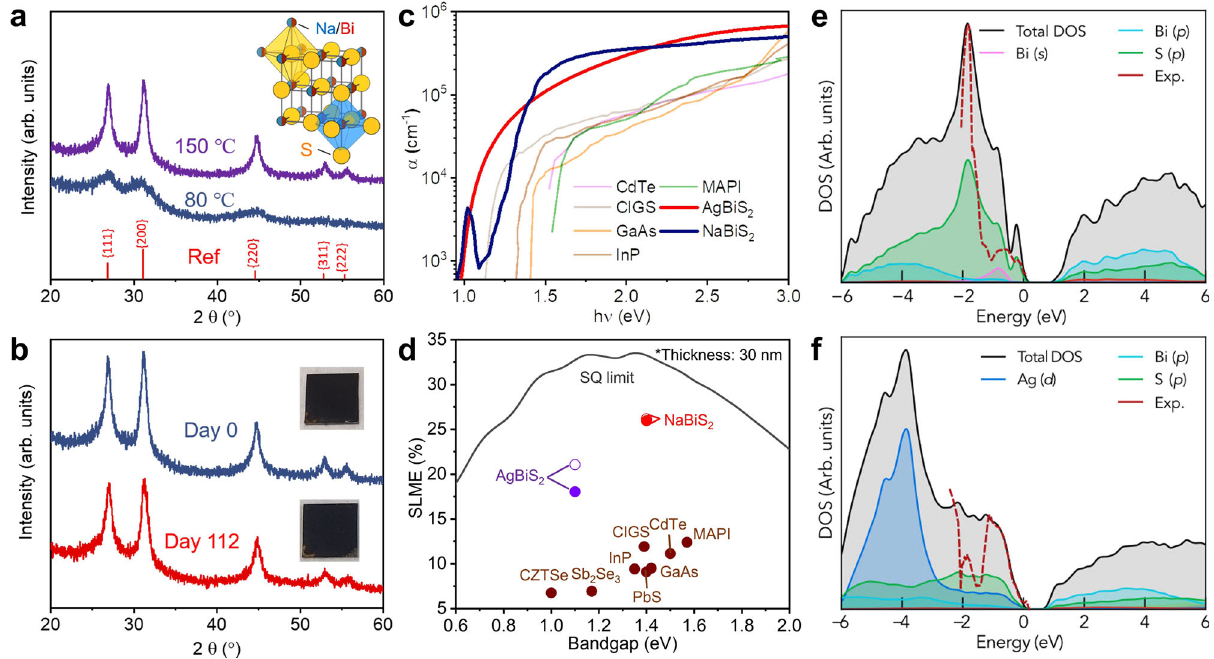
Fig. 1 | Structural and optical properties of NaBiS 2 NC fi lms. a X-ray diffraction (XRD) patterns of NaBiS 2 nanocrystals (NCs) synthesized at 80°C and 150°C compared with the referencepatternfor the disordered rocksalt ( Fm (cid:1) 3 m ) phase of NaBiS 2 28 . b XRDpatternsandphotographsofNaBiS 2 NC fi lmssynthesizedat150°C on the same day of preparation (Day 0) and after 112 days (Day 112) of storage in ambient air (60 – 70% relative humidity). c Absorption coef fi cient ( α ) spectrum of the NaBiS 2 NC fi lm compared with other PV absorbers. d Spectroscopic Limited Maximum Ef fi ciency (SLME) of various 30nm-thick PV absorbers compared with the Shockley-Queisser limit (SQ limit, black line). The hollow and solid circles for NaBiS 2 and AgBiS 2 refer to the corresponding SLMEs without and with con- sideration of non-radiative losses owing to indirect bandgaps (details in